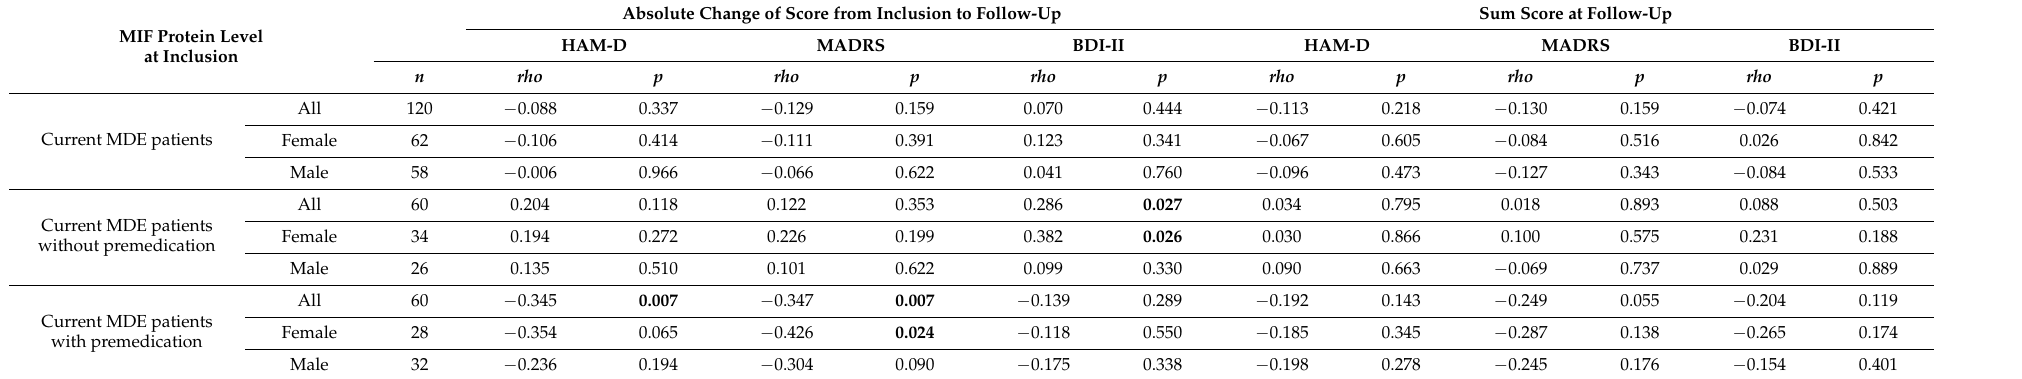
Table 3. MIF protein level at inclusion predicts absolute change of depression severity while there is no association with the score at follow-up as assessed by rating by a clinician (HAM-D and MADRS) or self-rating (BDI-II) in patients with a current MDE.